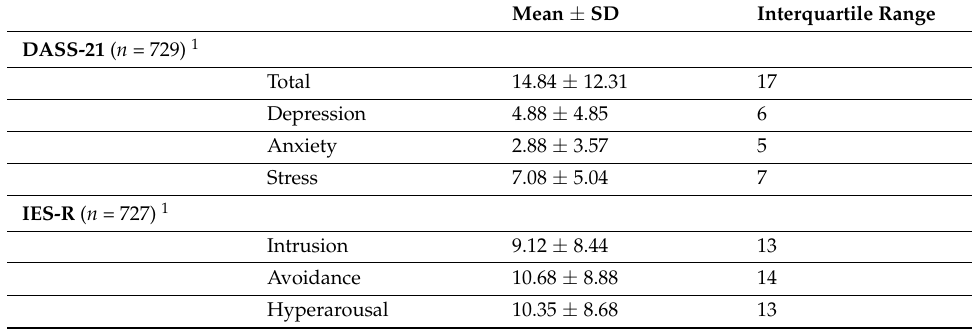
Table 2. DASS-21 and IES-R Scores of the Study